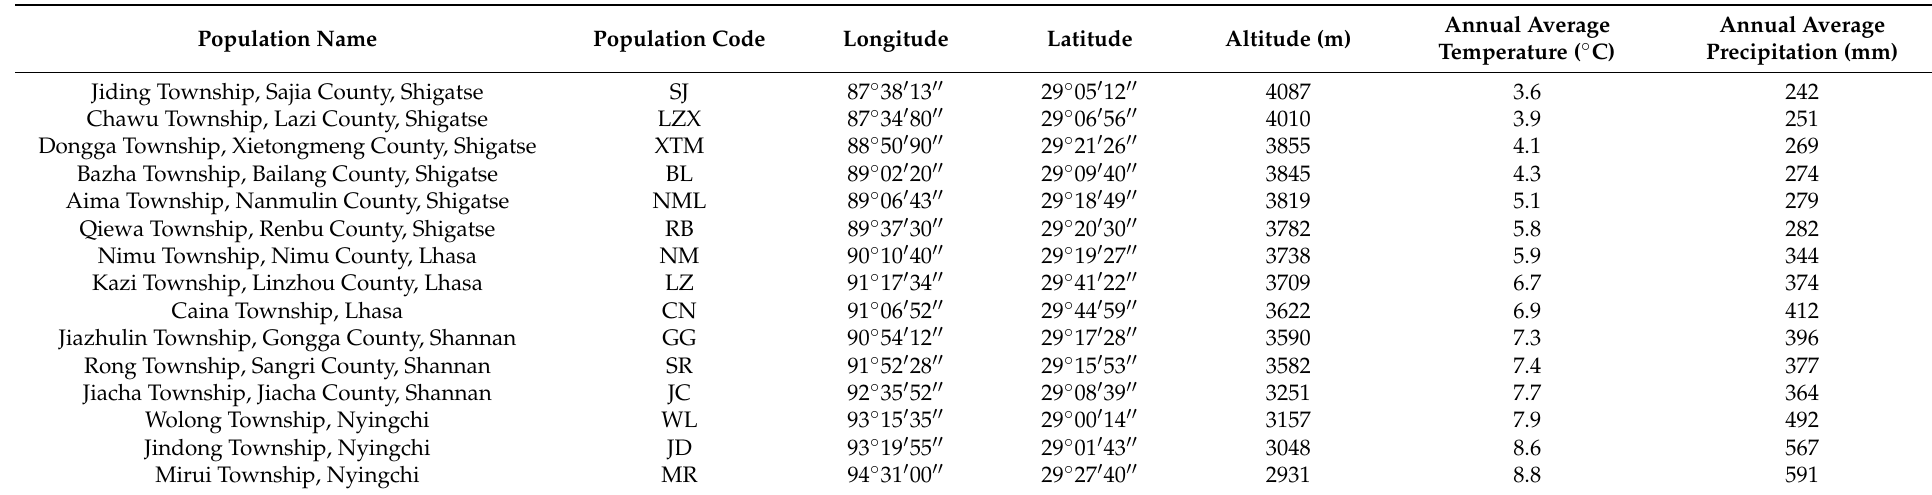
Climate data from the Resource and Environment Science and Data Center of the Chinese Academy of